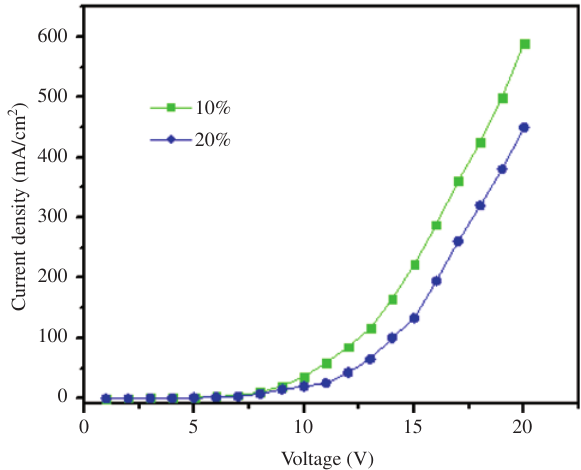
Figure 9: Current density (J)-voltage (V) characteristics of prepared OLED devices.